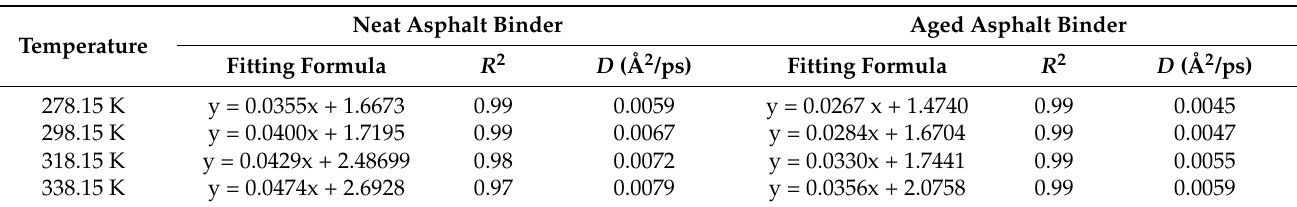
Table 3. Fitting equation and diffusion coefficient of neat/aged asphalt